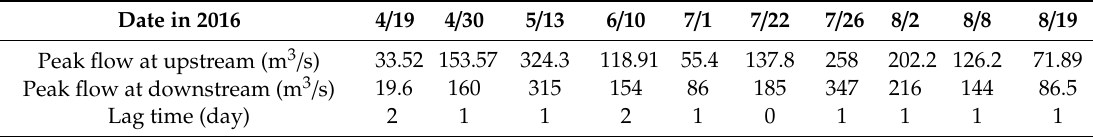
Table 3. Lag time statistics of typical flow peak in 2016.